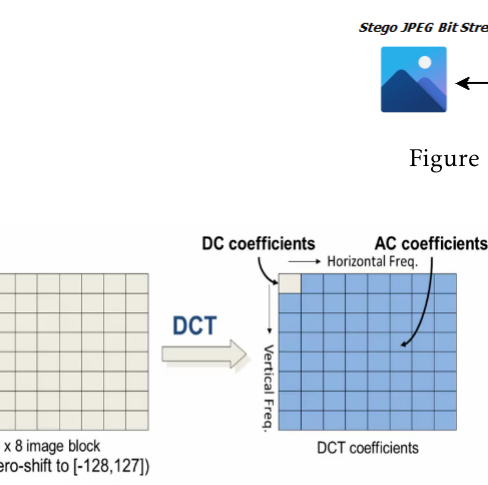
them more e ffi ciently. These blocks typically contain most of the image energy. The other 63 AC coe ffi cients starting from AC (0,1) are range coded after a Zigzag scan as shown in Figure 5.